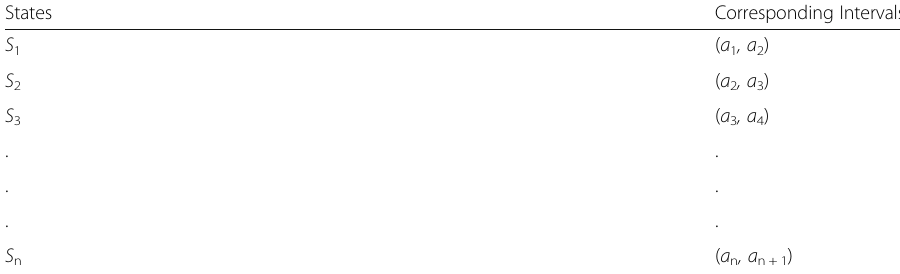
Table 1 States and the corresponding intervals of the jump analysis method States Corresponding Intervals